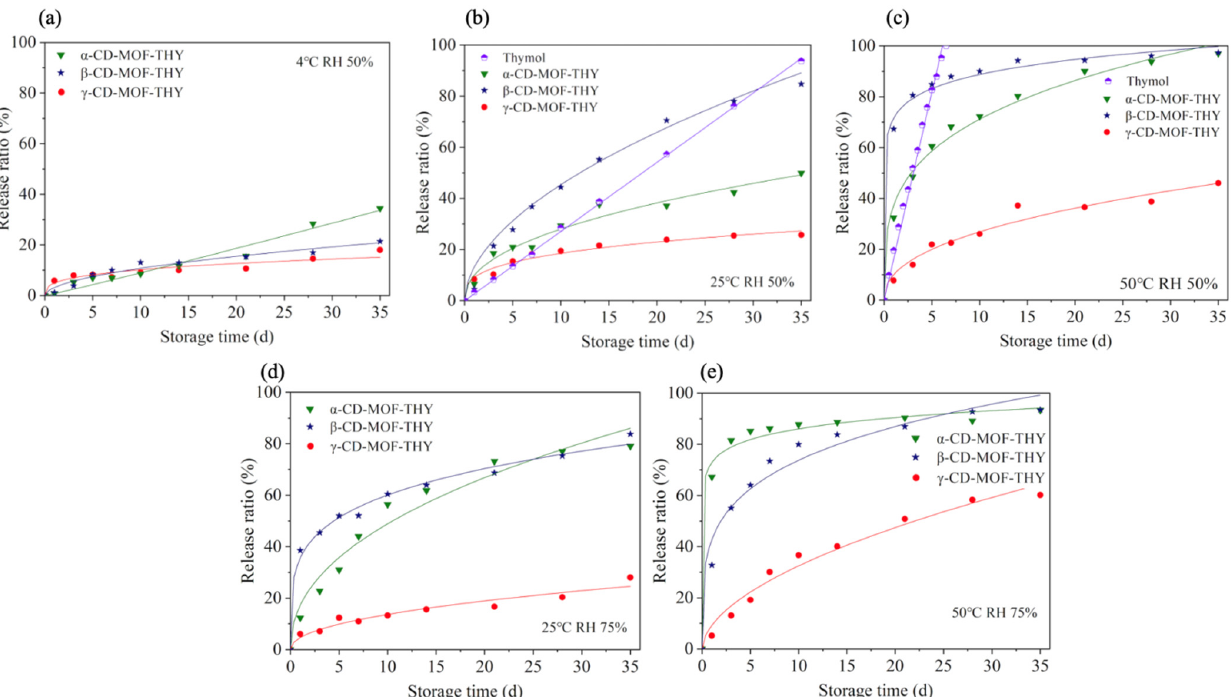
Figure 2. In vitro kinetics of thymol released from different γ -CD-MOFs at different temperatures and RH values stored for 0 to 35 days: ( a ) 4 ◦ C, RH 50%, ( b ) 25 ◦ C, RH 50%, ( c ) 25 ◦ C, RH 50%, ( d ) 50 ◦ C, RH 75% and ( e ) 50 ◦ C, RH 75%. p <